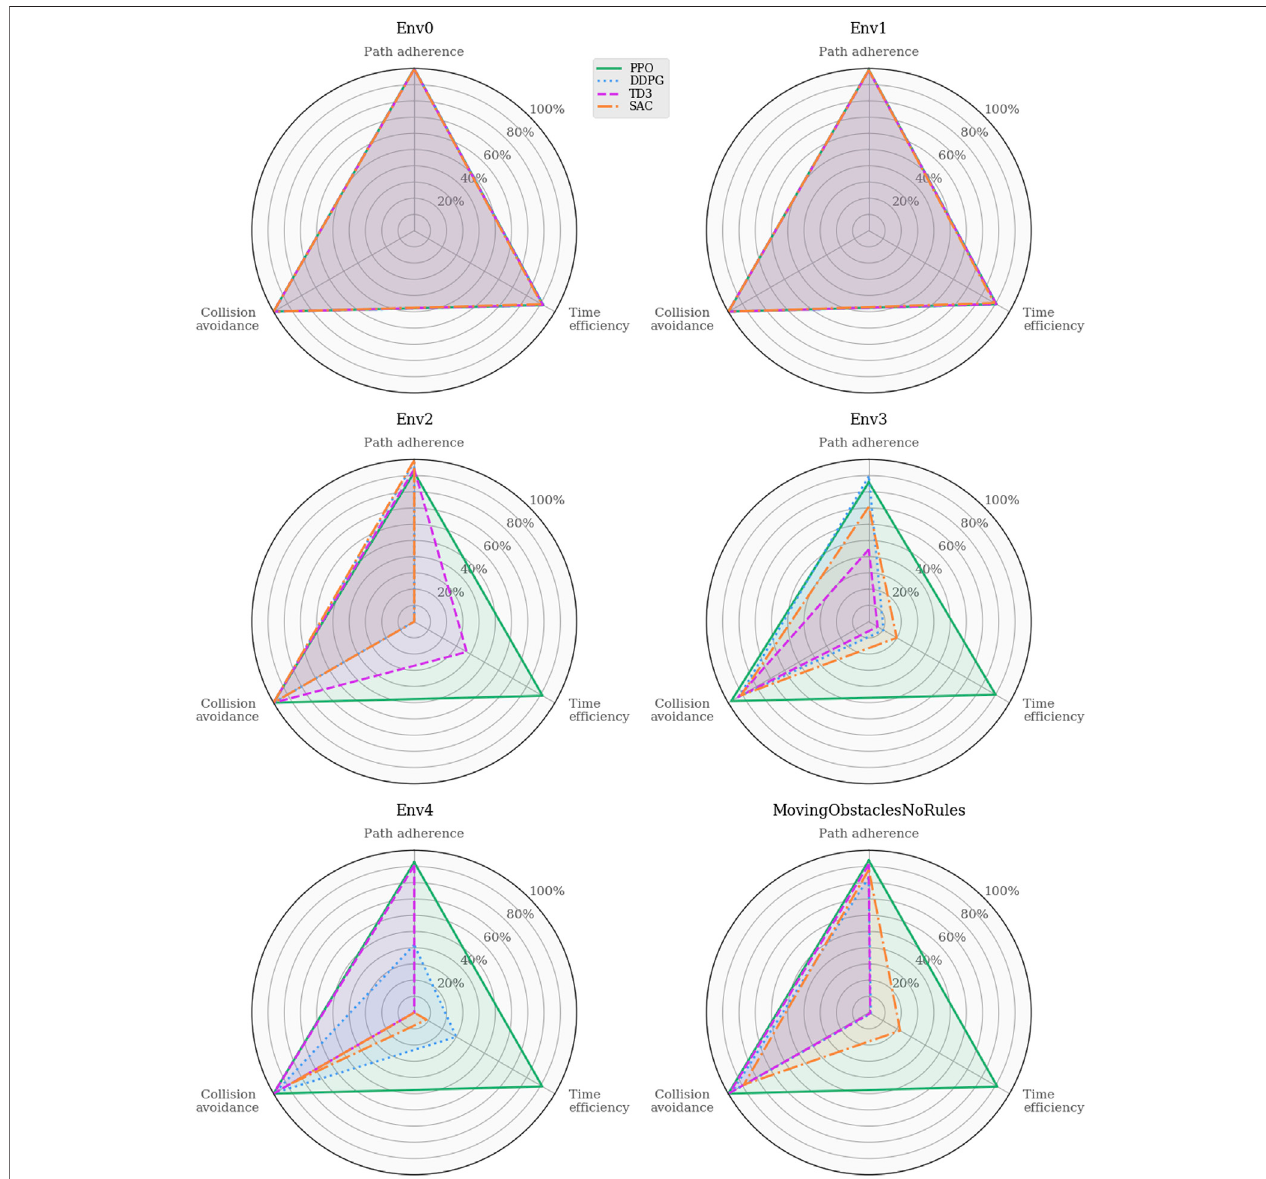
FIGURE 4 | Performance analysis of task-speci fi c metrics across the training environments. The indistinguishable behaviors in the trivial environments rule out critical software implementation faults for the added RL algorithms. Whereas the agents ’ capacity for collision avoidance remains near-perfect across all scenarios, the time ef fi ciency drops signi fi cantly for the off-policy algorithms in Env2 and subsequent training environments.